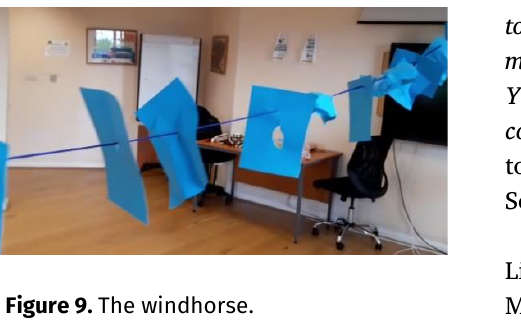
Figure 8. Ribbon tying, fire pages burning.